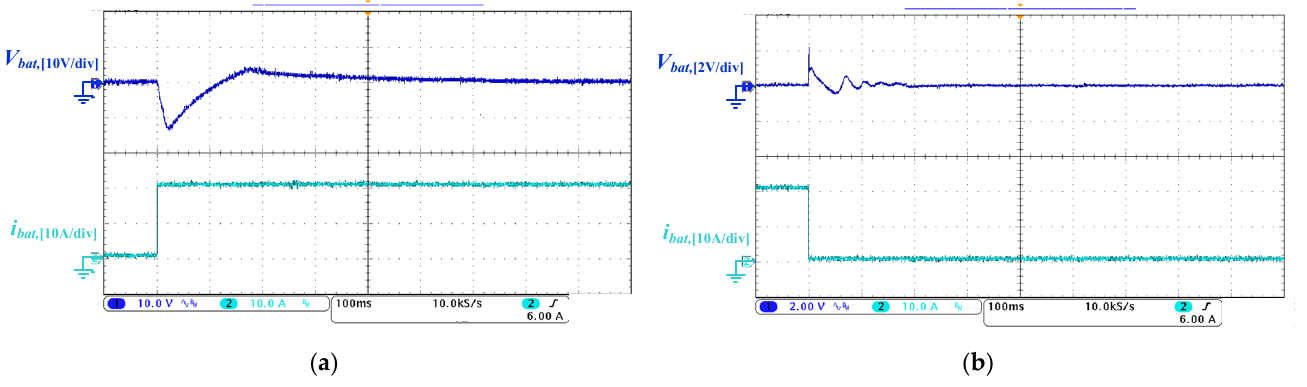
Figure 20. Step load response of prototype converter operating in forward power conversion mode: